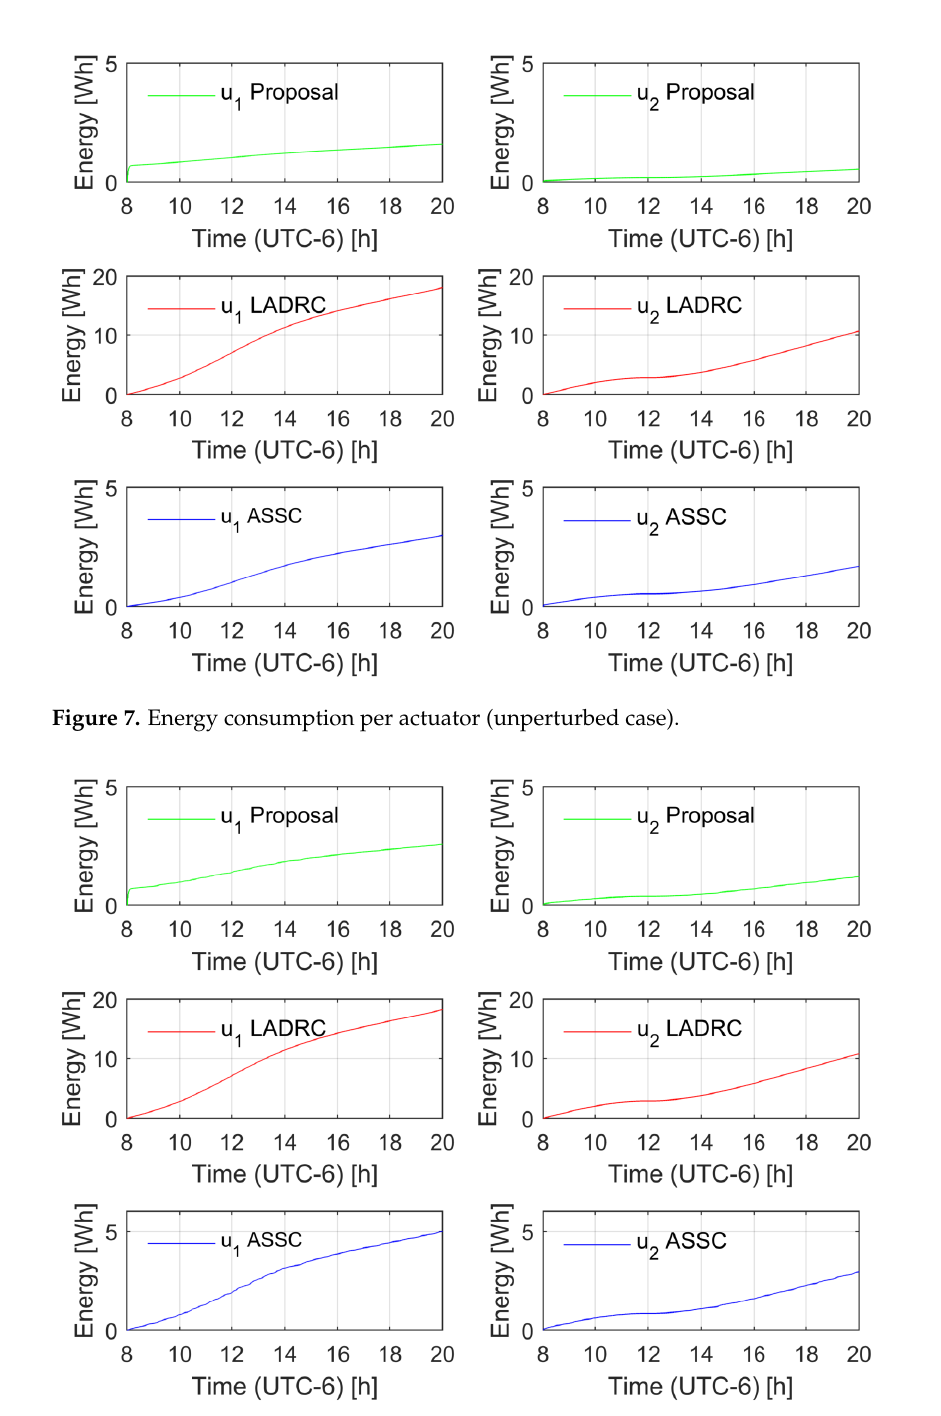
Figure 8. Energy consumption per actuator (perturbed